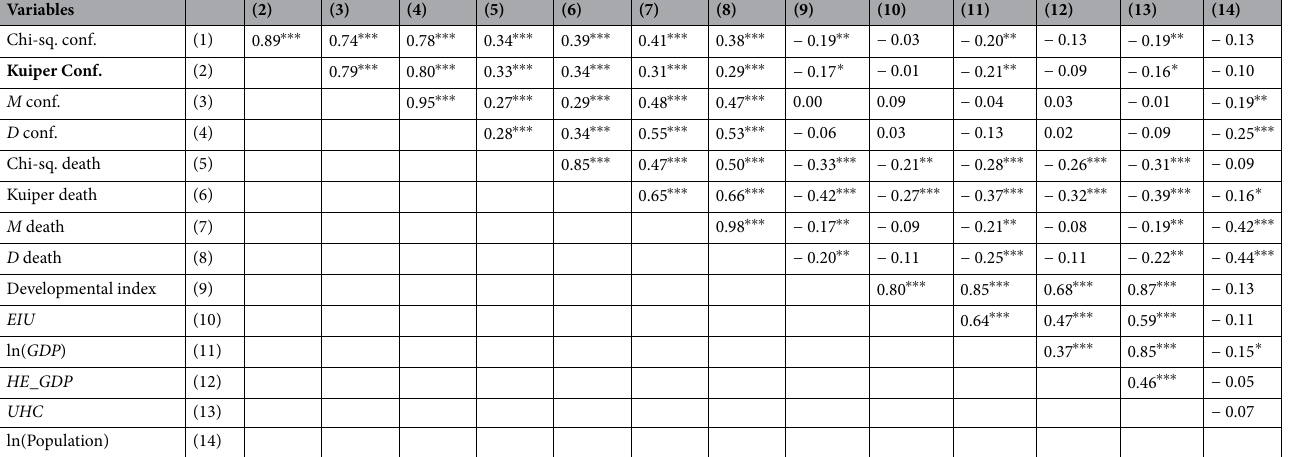
Table 2. Correlation matrix. This table presents the correlation matrix with Pearson correlation coefficients of the major variables. ***,**, and * denote significance at the 1%, 5% and 10% levels,